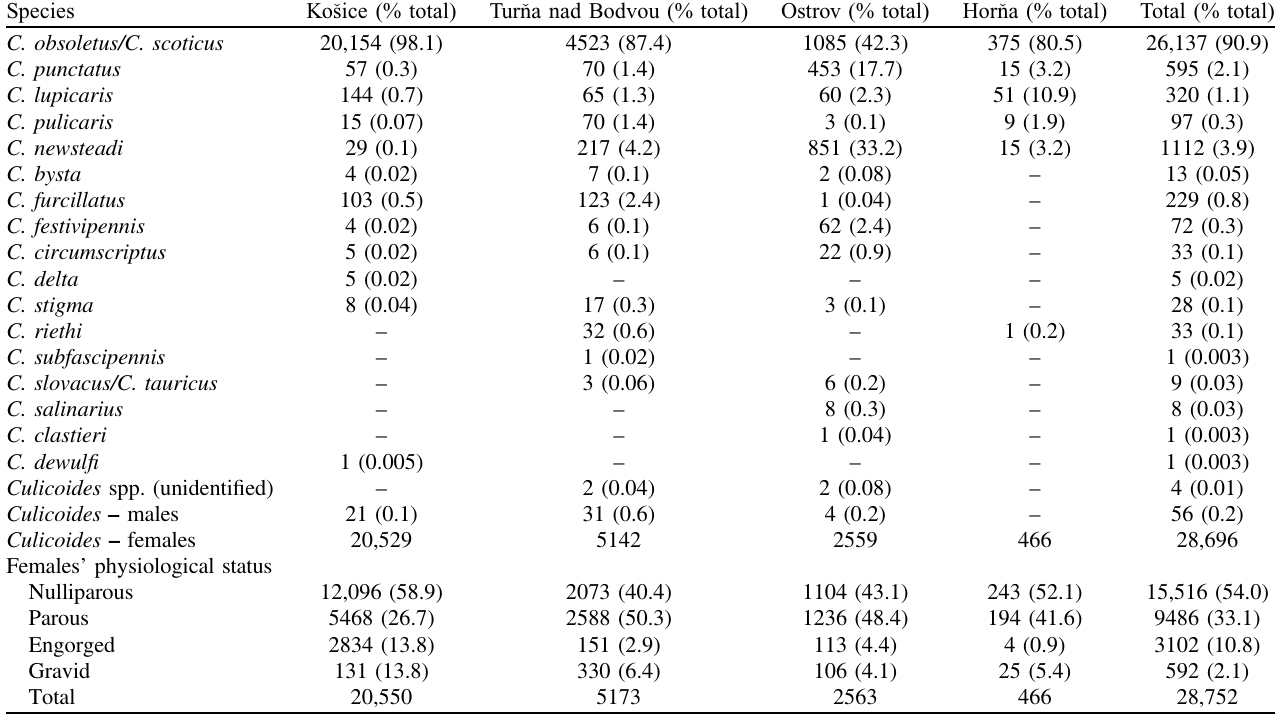
Table 2. Species and abundance of Culicoides females trapped on four